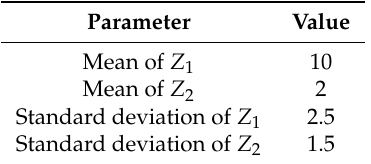
Table 3. Corrective affine distribution of Z 1 and Z 2